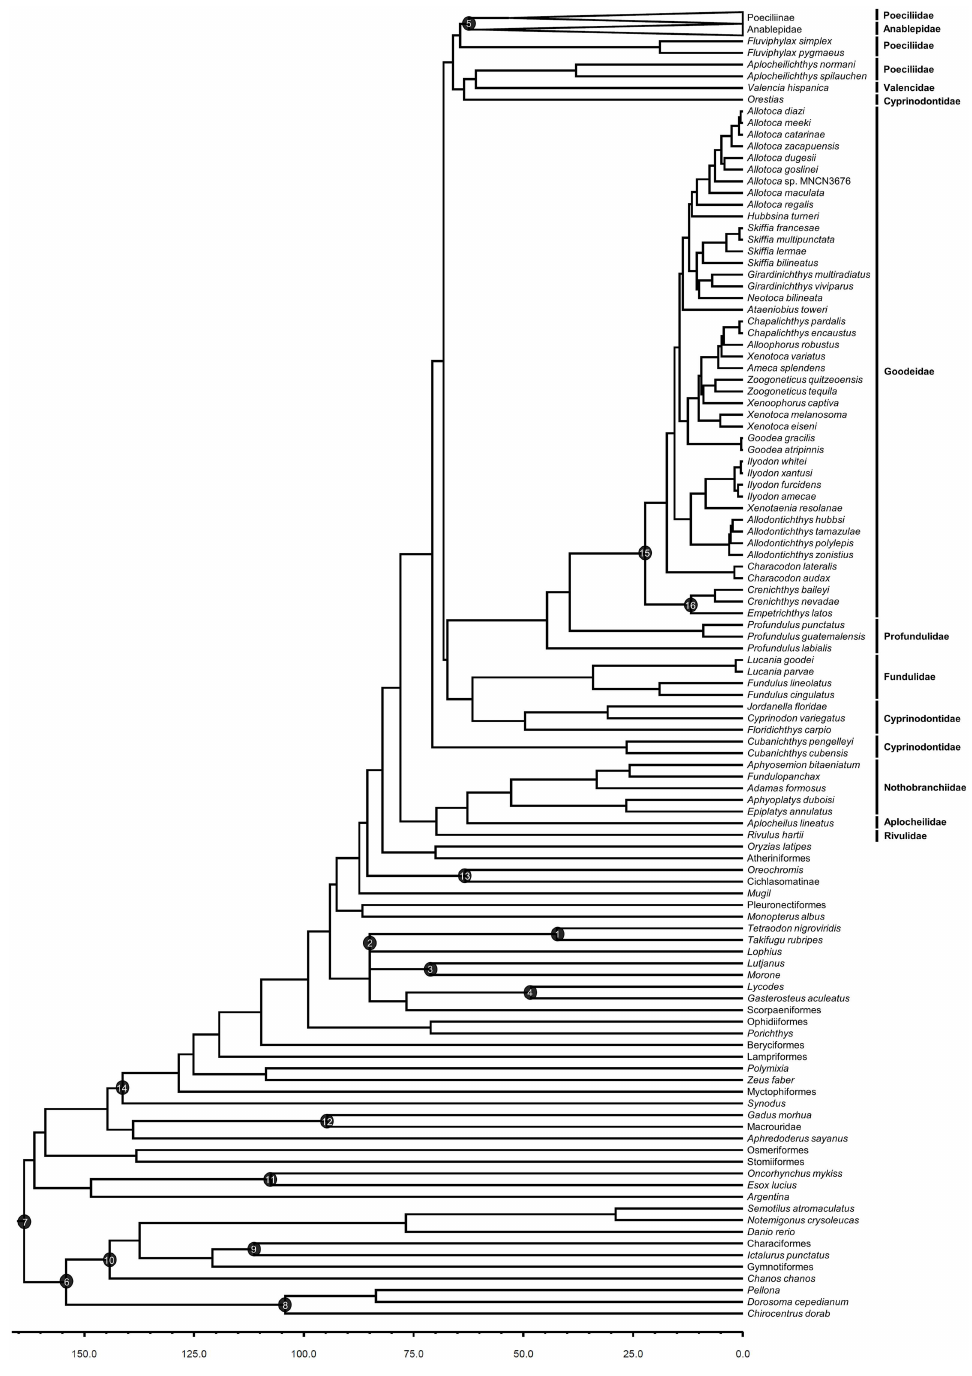
Fig 1. Timetree for 293 Cyprinodontiformes and outgroup taxa. Divergencetimes were estimated for Pollux et al.’s [9]RAxMLtree using the mcmctree program in PAML 4.4c [26] with autocorrelated rates and hard- bounded constraints. Numberednodescorrespondto the sixteen fossil calibrations describedin Materials and Methods. The estimated age for Tetraodontiformes to Lophiiformes(85.0 Ma) is youngerthan the minimum calibration age (96.9 Ma) for this node. Family names (right) are indicatedfor species in the order Cyprinodontiformes. The clades Poeciliinae and Anablepidae (top) have been collapsed; an expanded view of these clades can be found in Fig 2. The full timetree is availablein newickformat (S1 Table).